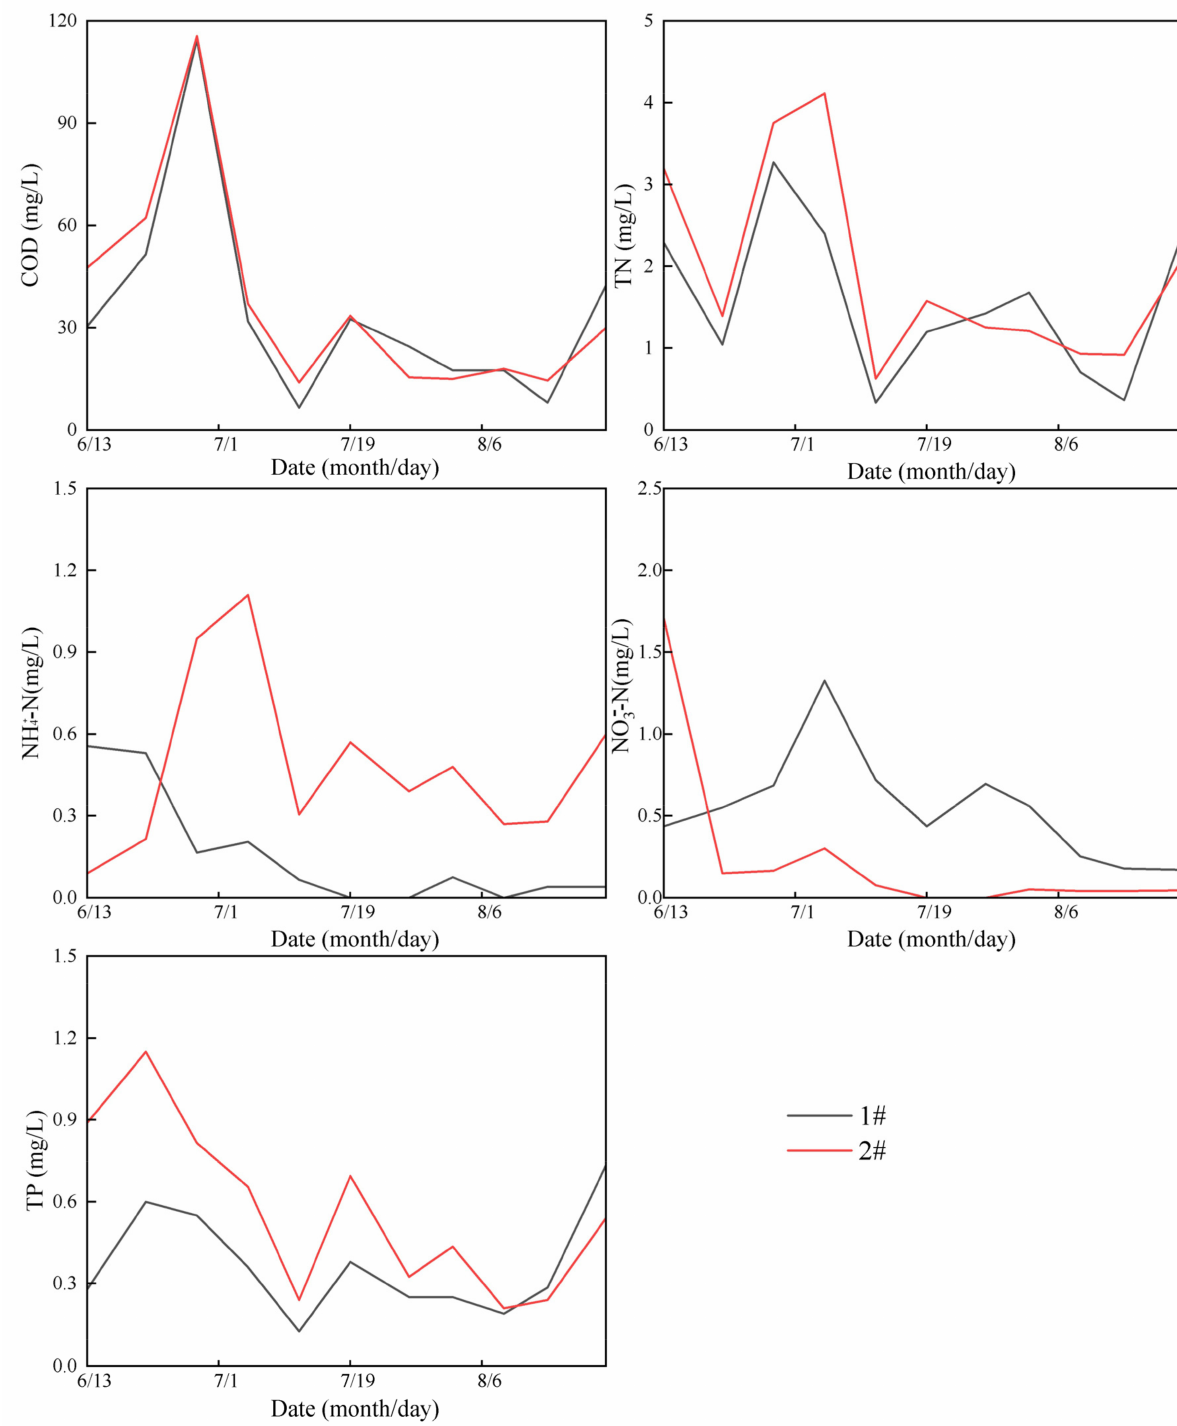
Figure 6. Comparison of COD, TN, TP, NH 4+ -N, and NO 3 − -N at two sampling points. Wang [38] found that fertilization could increase the NH 4+ -N concentration, but the effect on NO 3 − -N concentration was limited; however, in this paper, fertilization could increase the TN, NH 4+ -N, NO 3 − -N concentrations. The main reason for this difference is the different fertilization methods. In this paper, the surface spreading method was used to apply basal fertilizer and for topdressing, while Wang applied basal fertilizer with holes and topdressing on the surface. This method is conducive to the adsorption of nitrogen by soil particles, which makes the concentration of NO 3 − -N in the field